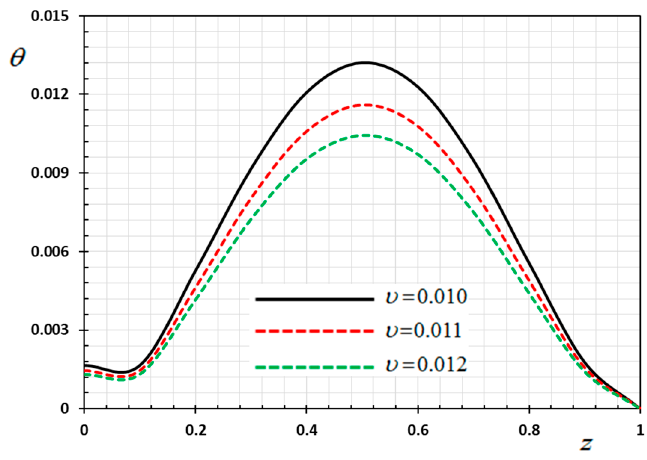
Figure 13. Variation of temperature 𝜃 versus 𝑧 for different velocity of the heat source 𝜐 .